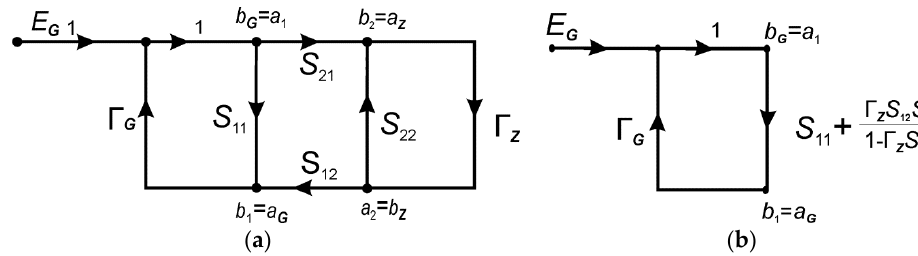
Figure 2. Directed graph of the electrical length control system: ( a ) total; ( b ) simplified.